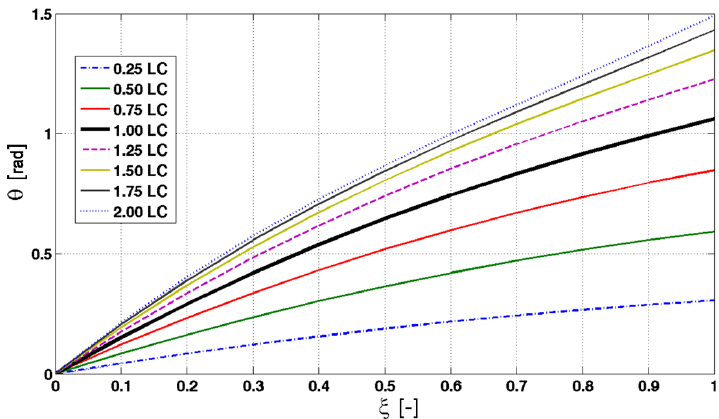
Figure 6. Slope along beam length of the flexible joint subject to di ff erent load cases (LC) from presented method. LC: β = 0 . 663 [ − ], α = 1 . 137 [ − ] corresponds to F w = 73 . 5mN; L w = 14mm; I = 2 . 5 × 10 − 13 mm 4 ; E = 150MPa.